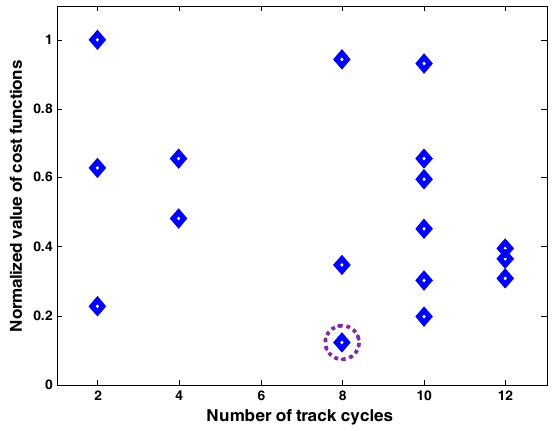
Figure 8. Number of time interval of 15 min utilized for the recharge of supercapacitors.